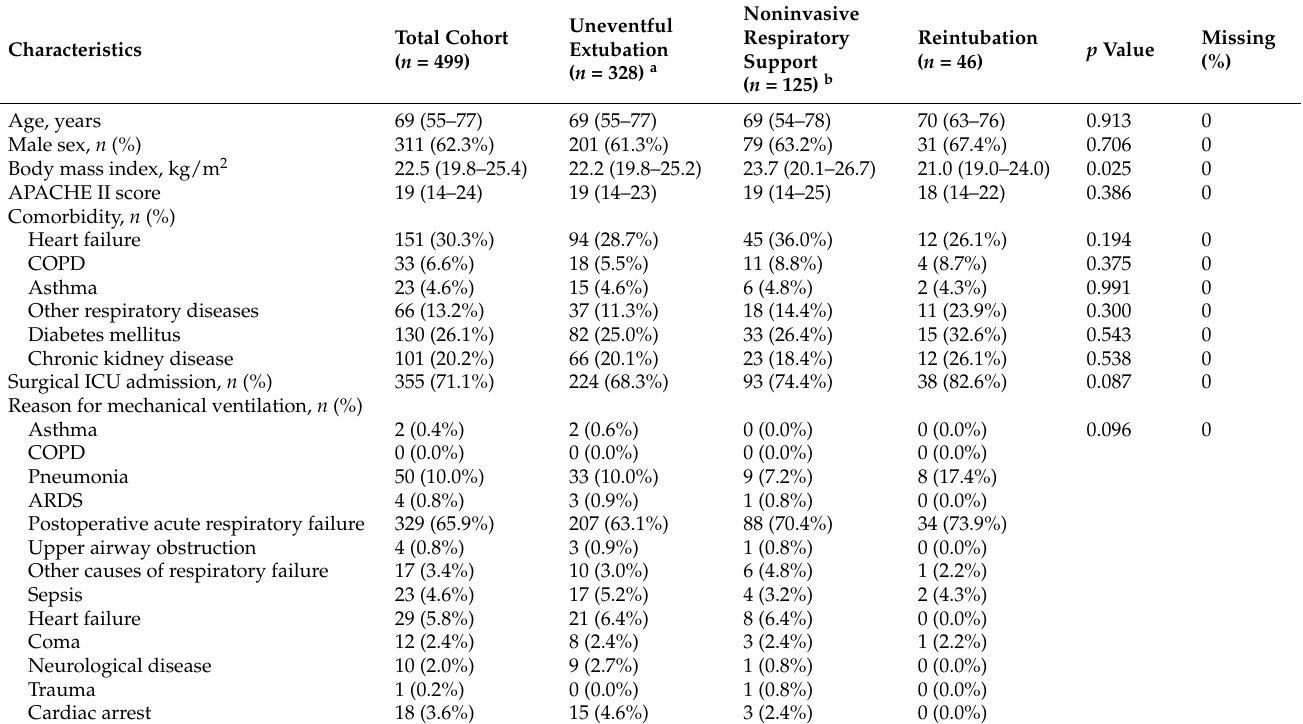
Table 1. Intubation characteristics of patients in the cohort study stratified by extubation